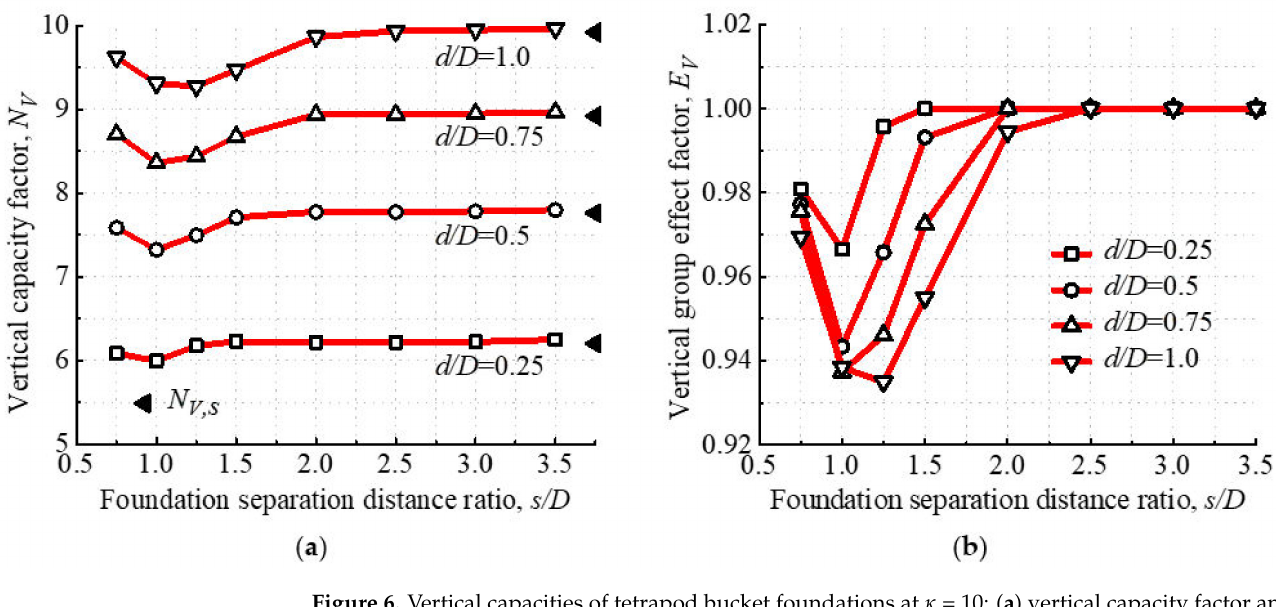
Figure 6. Vertical capacities of tetrapod bucket foundations at κ = 10: ( a ) vertical capacity factor and ( b ) vertical group effect factor.